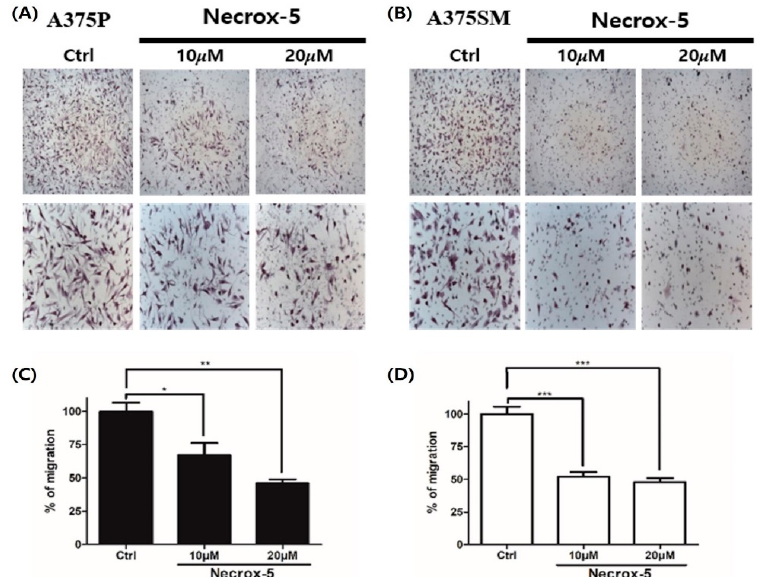
Figure 2. The effect of NecroX-5 treatment on melanoma cell migration. A375P and A375SM were inoculated in the upper chambers of transwell plates with 8- μ m pores with or without NecroX-5 at 10 μ M or 20 μ M. ( A , B ) After 24 h, the bottom side of the membrane was stained with hematoxylin, and a photographic image of the bottom of the transwell membrane was taken. ( C , D ) Migration of human melanoma cell lines was determined by counting three fields randomly selected at ×100–200 magnification from the upper chamber to the bottom side of the membrane. Results are expressed as the mean ± SEM from the three independent experiments. * p < 0.05, ** p < 0.01, *** p < 0.001.